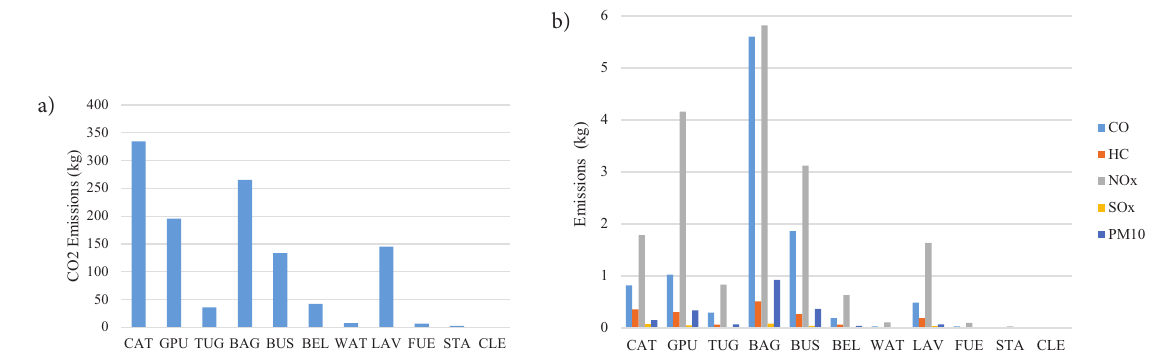
Figure 3. Emissions of each gas per GSE: a – CO 2 emissions per type of GSE; b – CO, HC, NOx, SOx and PM10 emissions per type of GSE (source: